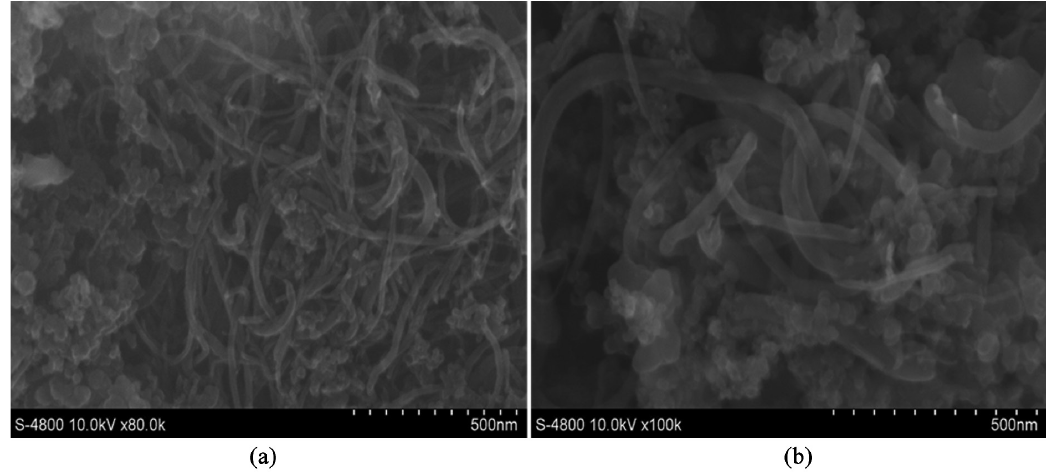
Figure 7. SEM images of LMO/CNTs (2 wt%) (a) and LNMO)/CNTs (2 wt%) (b) nanocomposites.